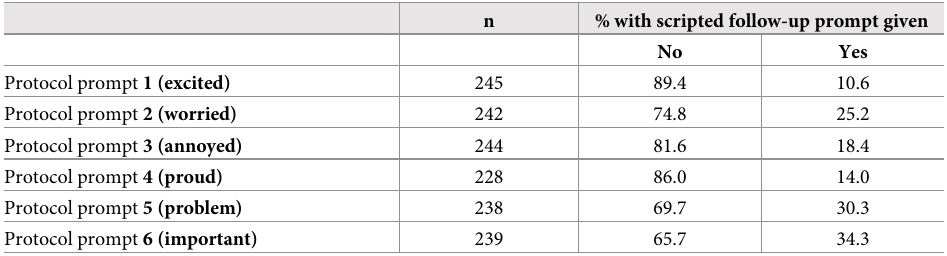
Table 3. Percentage of responses elicited with or without a scripted follow-up prompt, all countries combined. n % with scripted follow-up prompt given No Yes Protocol prompt 1 (excited) 245 89.4 10.6 Protocol prompt 2 (worried) 242 74.8 Protocol prompt 3 (annoyed) 244 Protocol prompt 4 (proud)